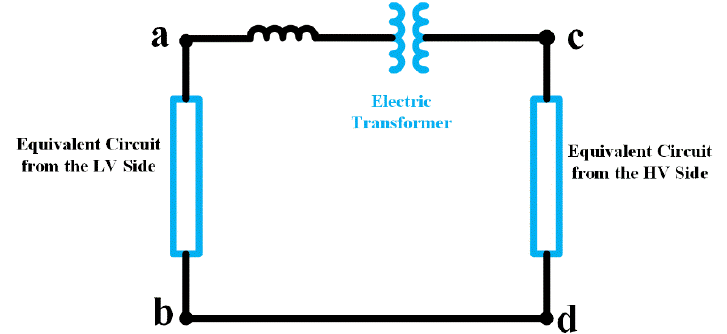
Figure 15. PWM and Phase-Shift Control equivalent circuit.